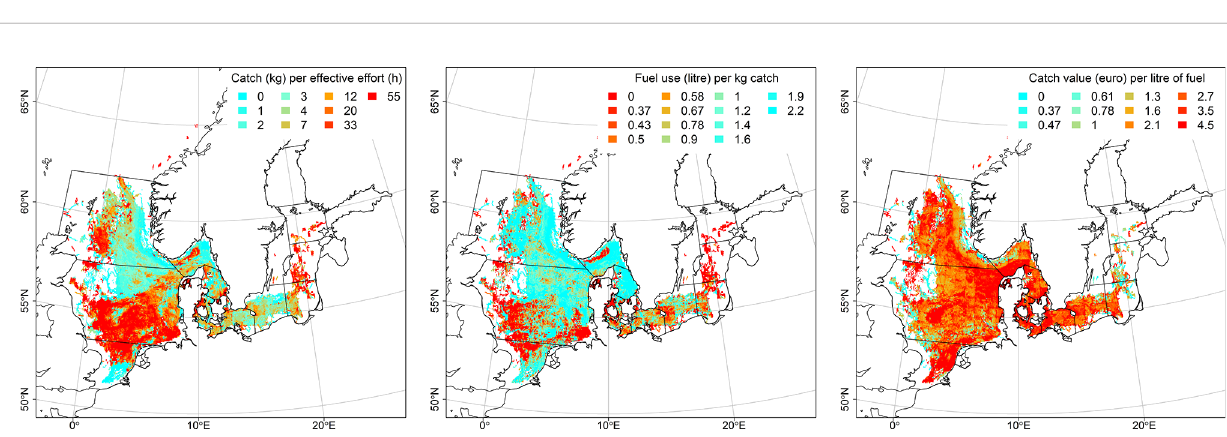
economically ef fi cient fi shing in this fl eet segment occurred close to Danish coasts with seine and bottom trawling for cod in the Baltic Sea or gillnetting for cod, plaice and sole ( Figure 4 ). The differences in ef fi ciency among seining and bottom trawling for mixed demersal fi sheries in the Baltic Sea compared to the North Sea and mixed crustacean fi sheries re fl ect differences in EUR per unit effort and landing values ( Supplementary Material Figure 9 ). Hence, the less fuel-intense